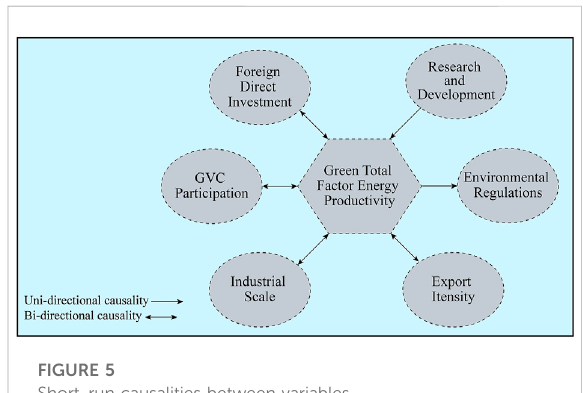
FIGURE 5 Short-run causalities between